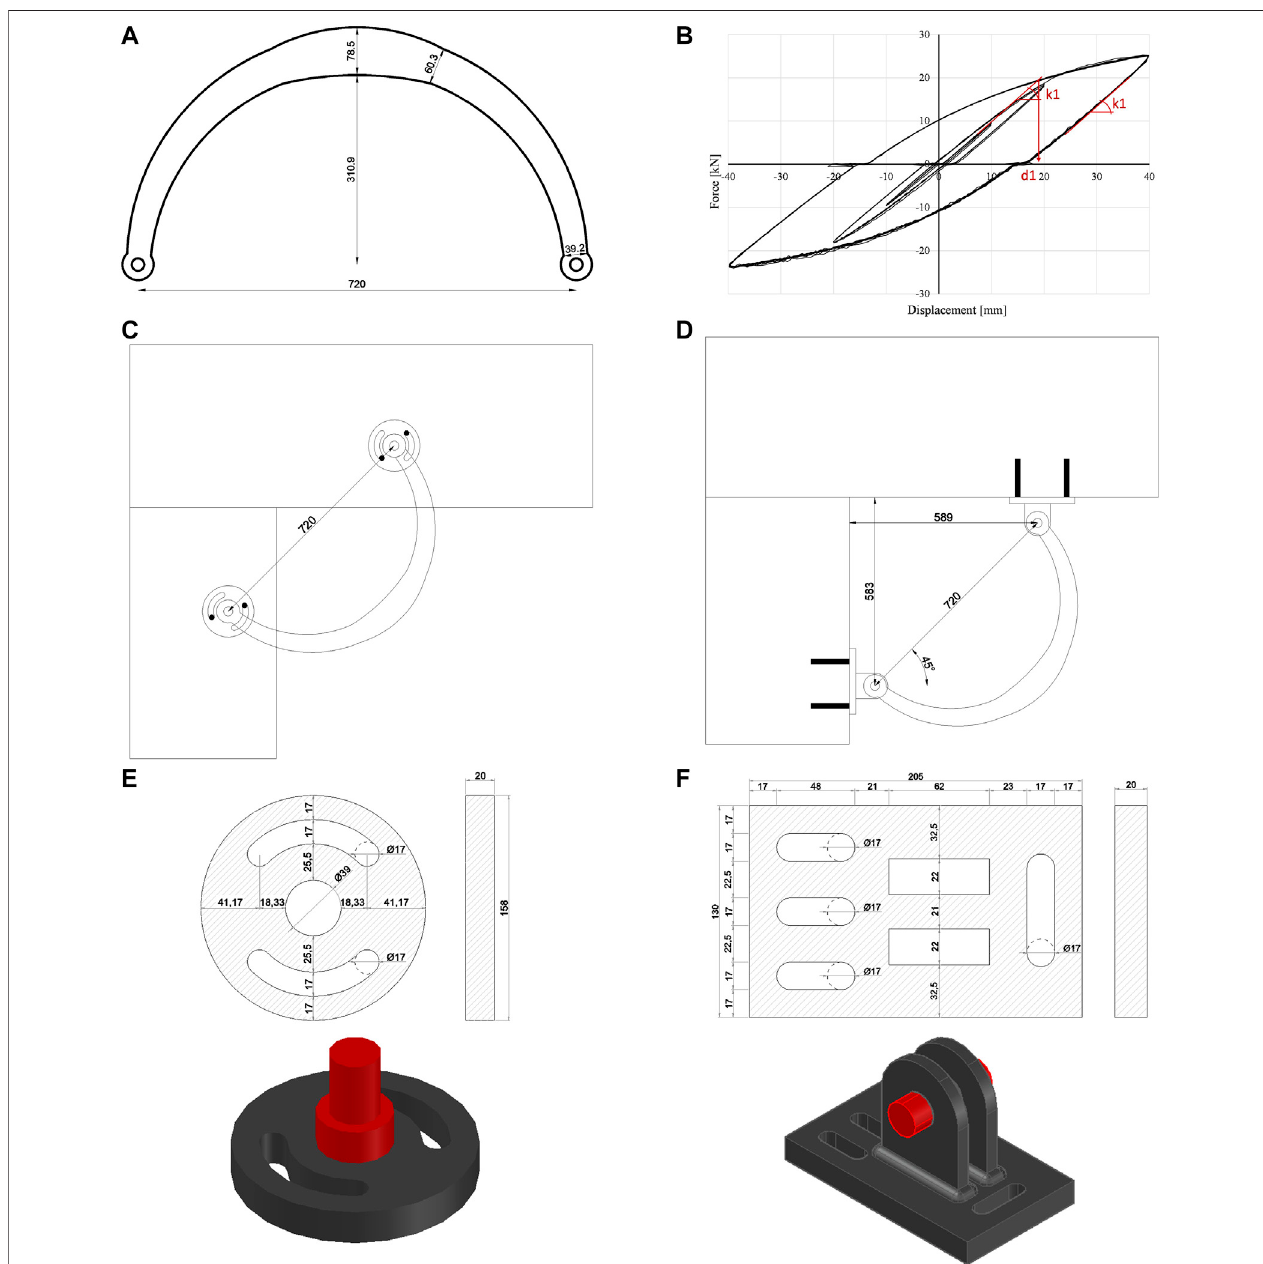
FIGURE 5 | Geometry of the beam-to-column device (A) ; experimental force-displacement behavior (B) ; application of the device on beam and column from the side (C) and from below (D) ; geometry of the end-plates (E, F) .